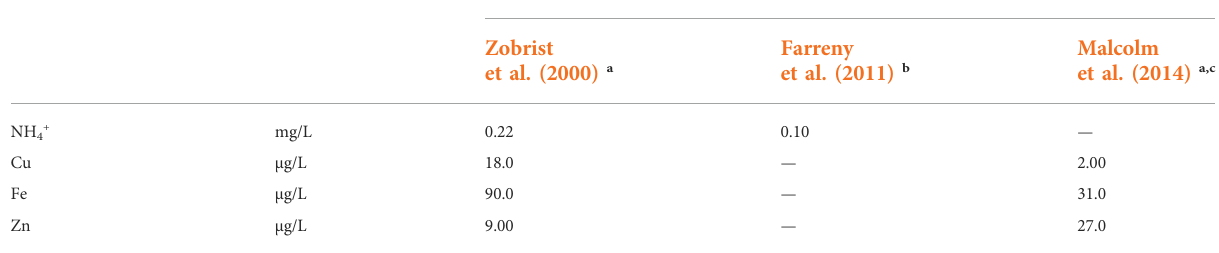
TABLE 2 Values of different parameters in fl at gravel roof